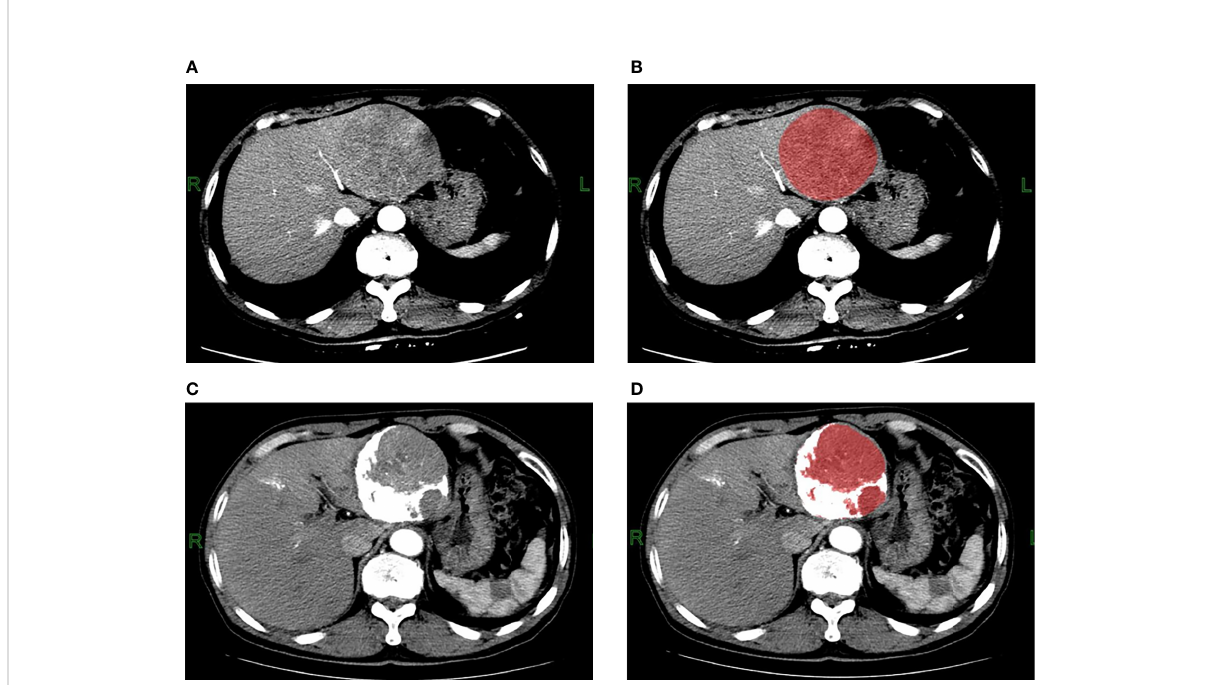
FIGURE 2 Contrast-enhanced CT arterial phase images and the ROI images before TACE treatment. (A, B) A 62-year-old male patient with hepatitis B and small three-yang, AFP greater than 80000ng/L before TACE treatment; three-phase enhanced CT examination 5 days before treatment showed that the lesion was located in the left lobe of the liver, with a maximum cross-section of about 90mm*85mm, no cirrhosis, no portal vein tumor thrombus or arteriovenous fi stula, with heterogeneous enhancement in the arterial phase. The ROI was manually delineated using the FireVoxel software, and the grayscale histogram parameters were extracted for texture analysis. Contrast-enhanced CT arterial phase images and ROI images after TACE treatment. (C, D) The patient underwent three-phase enhanced CT examination 39 days after TACE treatment. The maximum section of the lesion was about 83mm*77mm, and the TACE treatment effect was evaluated as stable disease SD. After delineating the ROI, the CT value was used to split the ROI, the white area larger than 200Hu was the lipiodol deposition, and the red area smaller than 200Hu was the fi nal ROI, the texture analysis of the fi nal ROI was